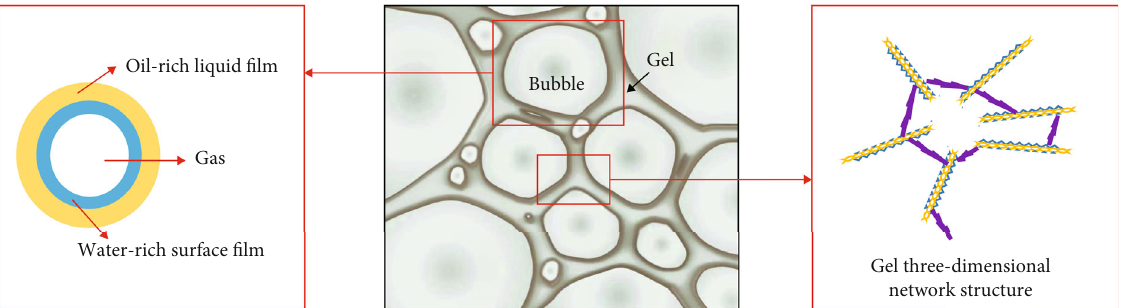
Figure 12: Schematic diagram of oil-based foam gel structure.